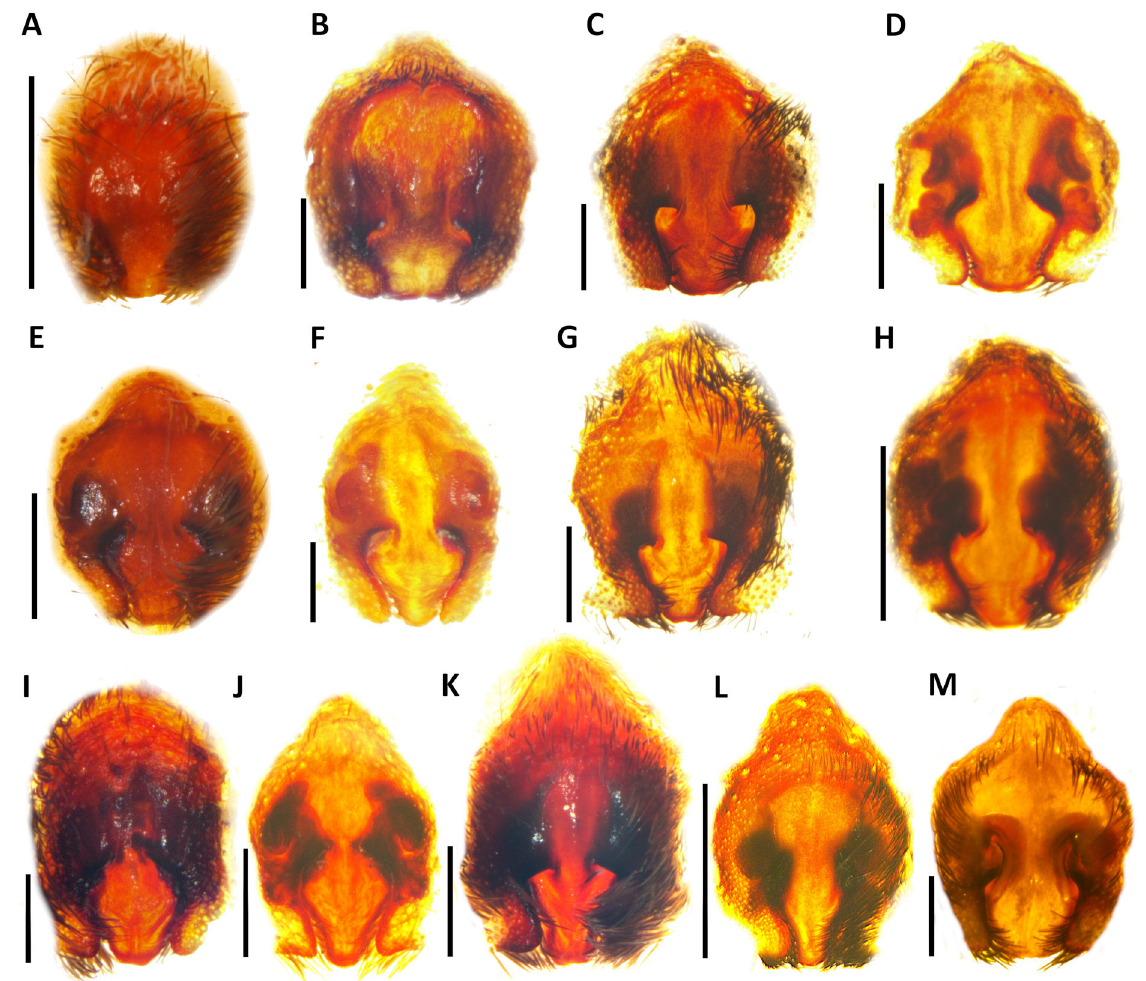
Fig. 9. Epigynes, ventral view. A . Lycosa sp. (HUJ INV-AR20573). B . Lycosa hyraculus sp. nov . , paratype (HUJ INV-AR20817). C–L . Lycosa piochardi Simon, 1876. C . HUJ INV-AR20607. D . HUJ INV-AR20912. E . HUJ INV-AR20671. F . SMFD2184. G . HUJ INV-AR20963. H . HUJ INV-AR20709. I . HUJ INV-AR20897. J . HUJ INV-AR20530. K . HUJ INV-AR20860. L . HUJ INV-AR20758. M . Lycosa praegrandis C.L. Koch, 1836 (Veles, North Macedonia, 1 Jun. 2002; courtesy of Marjan Komnenov). Scale bars = 0.5 mm. Photos by I. Armiach